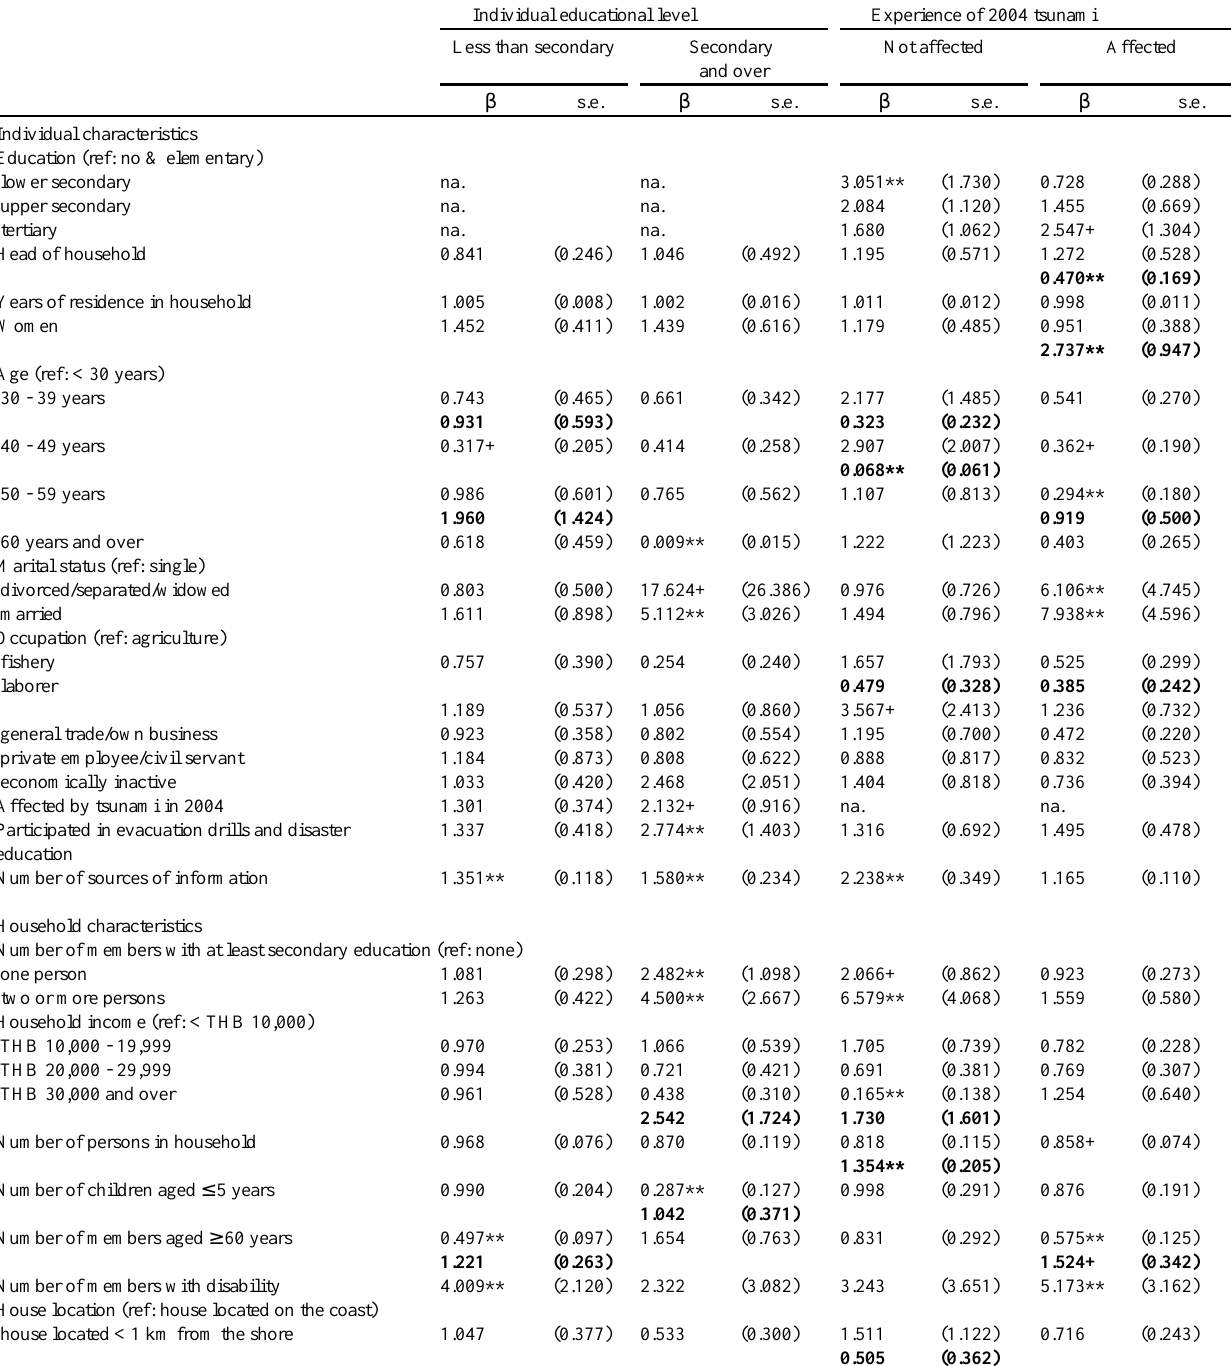
Table 3 . Odds ratio estimated from partial proportion odds ordered logit models predicting disaster preparedness with village indicators: samples split by respondents’ level of education and experience of the 2004